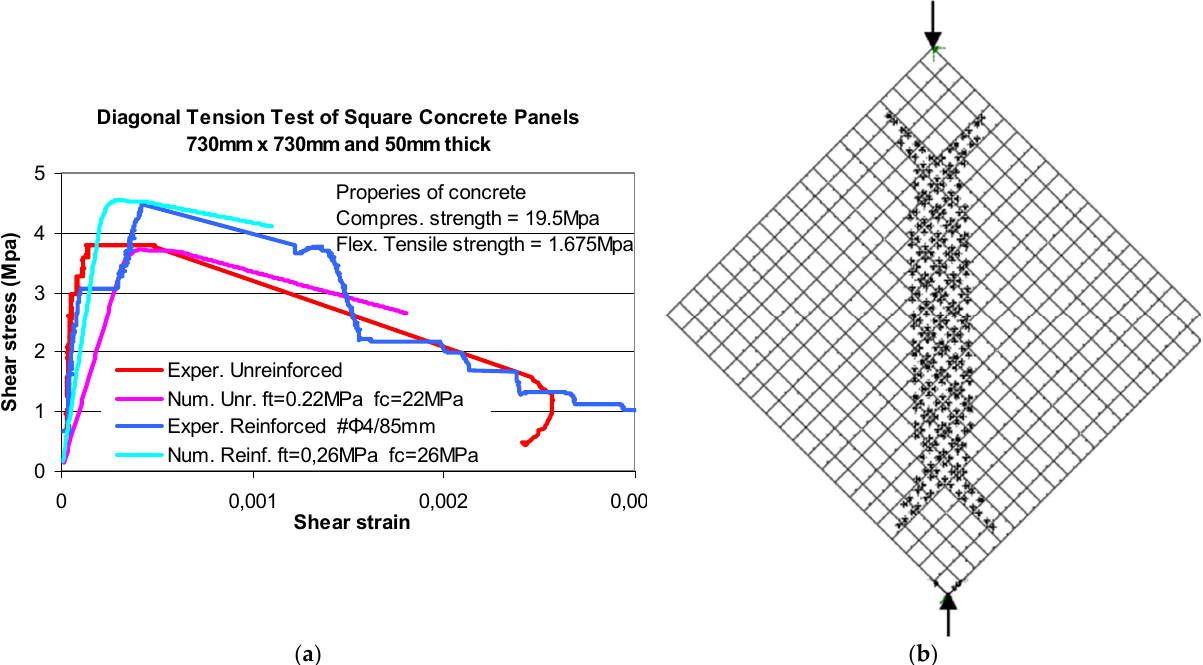
Figure 20. Diagonal compression–tension. ( a ) Comparison between observed and numerically simulated behaviour of the tested square concrete panels. ( b ) Predicted plastified regions from the numerical simulation.